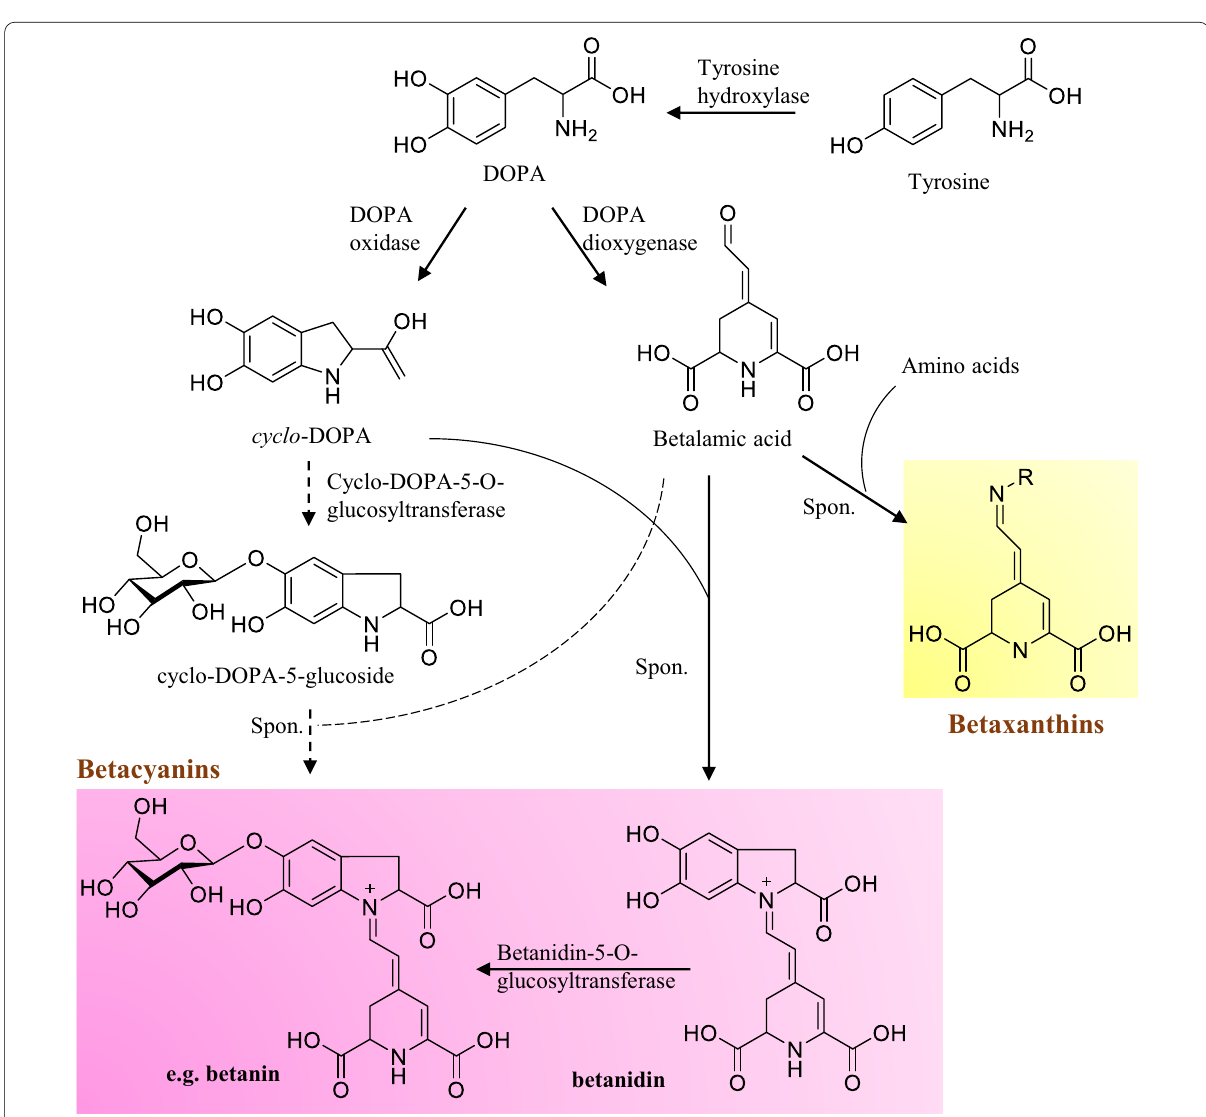
Fig. 11 Schematic of betalains biosynthesis. Betalains can be subdivided into betacyanins (red–violet) and betaxanthins (yellow–orange), whereby betacyanins are formed by conjugating betalamic acid with cyclo-dihydroxyphenylalanine (cDOPA) glucoside while betaxanthins result from the condensation of betalamic acid with amino acids or amines. DOPA,